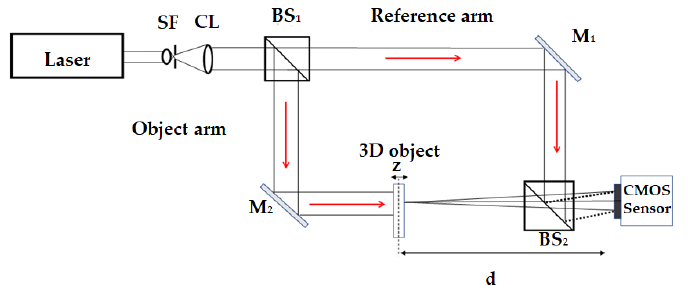
Figure 2. Off-axis digital holographic recording geometry used for the recording of holograms of 3D objects. SF: spatial filter assembly; CL: collimation lens; BS: beam splitter; M: mirror; CMOS: camera sensor.